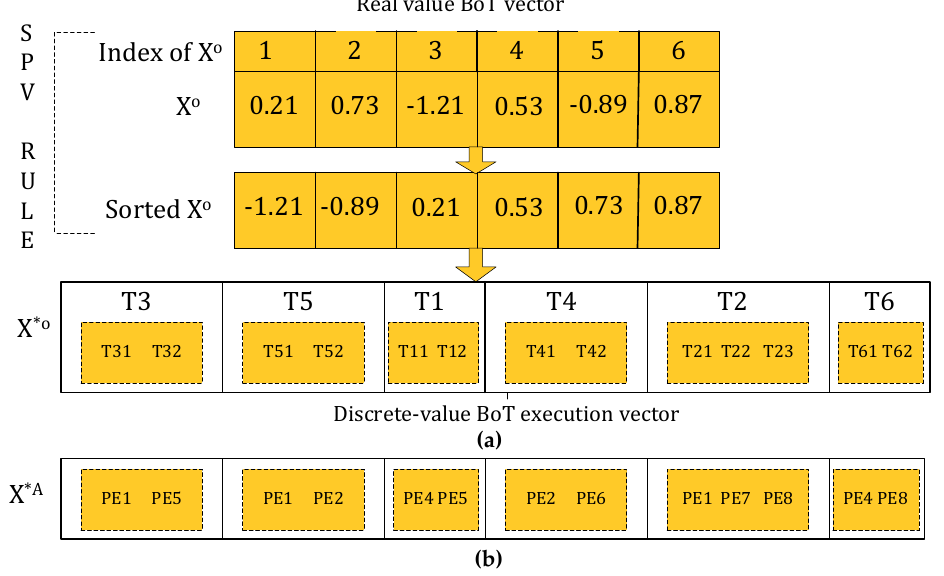
vector applying SPV method, ( b ) Example vector applying MDeRA heuristic. ∗𝑂𝑂 𝑋𝑋 ∗𝐶𝐶 𝑋𝑋